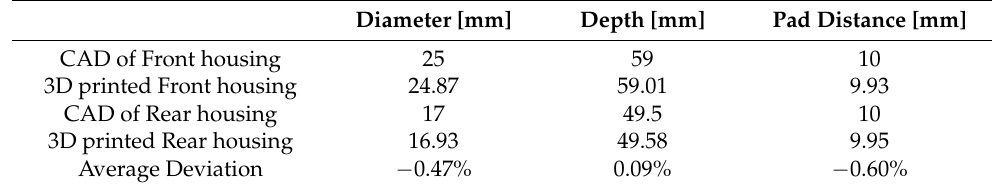
Table 1. Geometric deviations between the CAD models and the 3D printed parts of the housings.